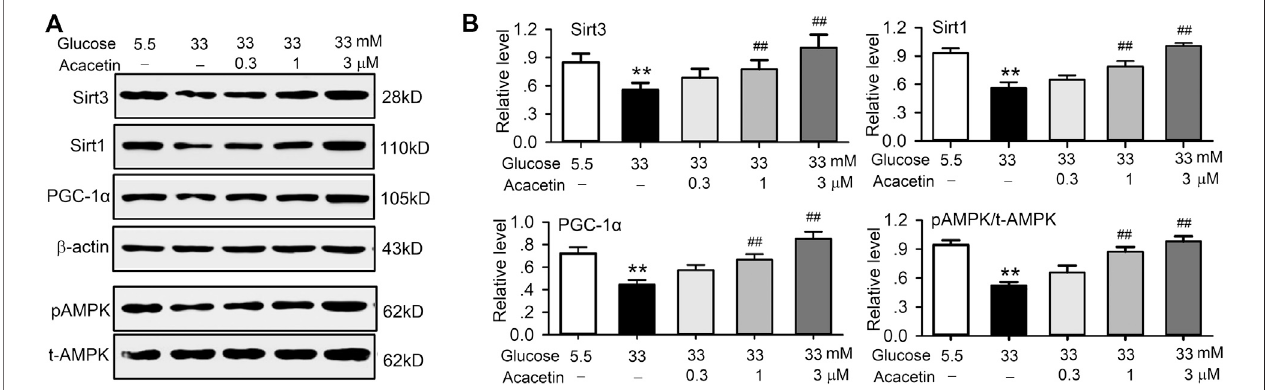
FIGURE 5 | Acacetin rescued the impaired signal molecules induced by high glucose exposure in HUVECs. (A) Western blots of Sirt3 Sirt1, PGC-1 α , pAMPK, t-AMPK in HUVECs cultured in 5.5 mM glucose or 33 mM glucose in the absence or presence of 0.3, 1, or 3 μ M acacetin. (B) Acacetin reversed the decrease of Sirt3, Sirt1, PGC-1 α and pAMPK in a concentration-dependent manner. n (cid:2) 5 individual experiments, ** p < 0.01 vs. 5.5 mM glucose; ## p < 0.01 vs. 33 mM glucose alone.